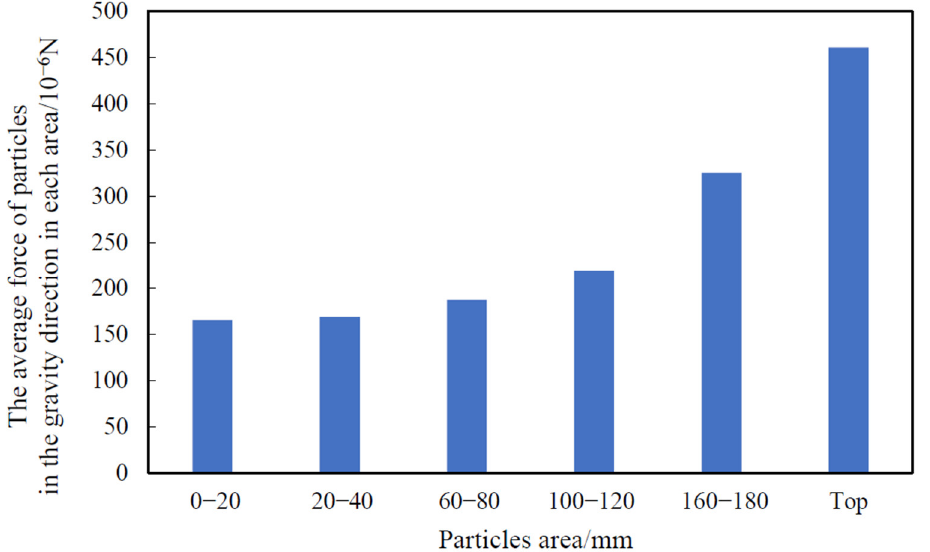
Figure 10. Average force of corn grain in each area over 0–5 s (bar chart after taking absolute value). There were significant differences in the movement between layers of corn grain ac- cumulated in the cylindrical storage cylinder, including the amplitude of average velocity fluctuation, the speed of fluctuation per unit time and the significance of pulsation char- acteristics. The grain layers were related to each other, including similar pulsation wave- forms and the same pulsation period. Corn grains not only were limited to the whole grain cylinder system but also had independent movement characteristics. 3.2. Effect of the Half Cone Angle on the Pulsation Characteristics of the Grain Layer The above studies revealed the pulsation characteristics of the grain layer at different heights. The characteristics of periodic pulsation became more prominent with increasing grain layer height. To analyze the influence of different half cone angles on periodic pul- sation characteristics, a simulation analysis of grain unloading was carried out in seven groups of different half cone angles. The variation in the average velocity over time for corn grains in the area below 20 mm on the upper free surface was extracted with half cone angles of 30°, 45° and 60°. We considered a half cone angle of 45° as an example. The change in average velocity over time in the area below 20 mm on the free surface of the corn grain during the 15 s time period of grain unloading in the grain cylinder was extracted, as shown in Figure 11. The corn grain was in the fluctuating stage during the whole grain unloading stage. The period of 0–0.5 s marked the beginning stage of grain unloading. The speed fluctuation range was small at this time. It had a clearly visible single peak and did not have a periodic